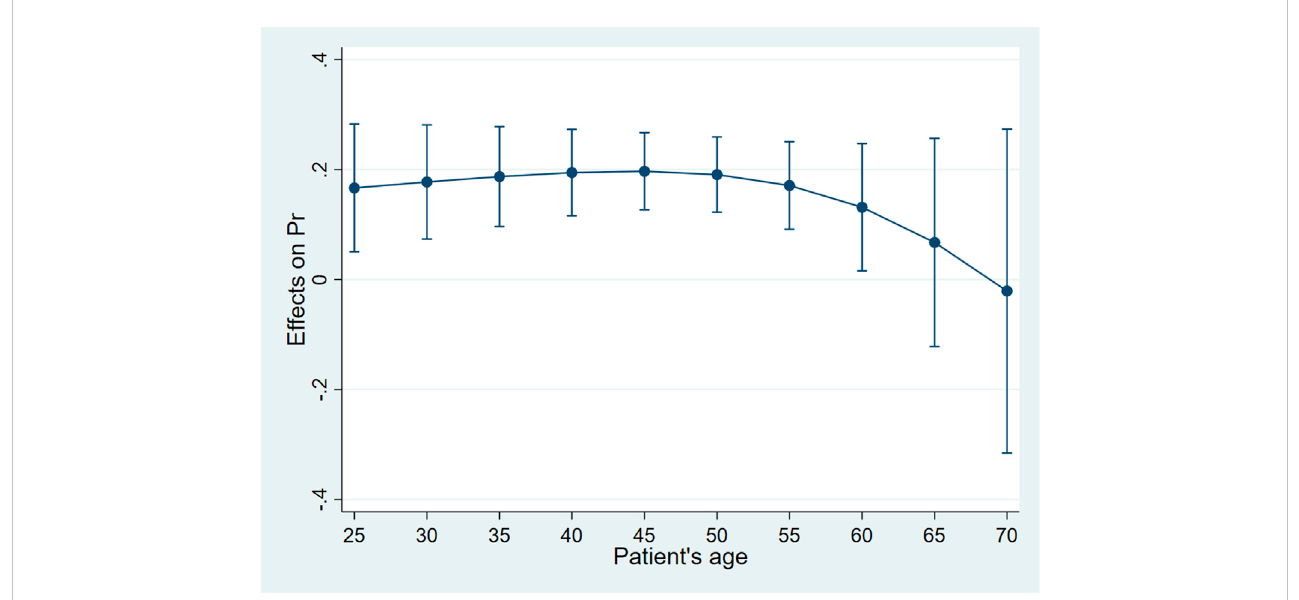
FIGURE 2 Average marginal effects of attending physician ’ s academic rank with 95% CI when patients were of different ages.